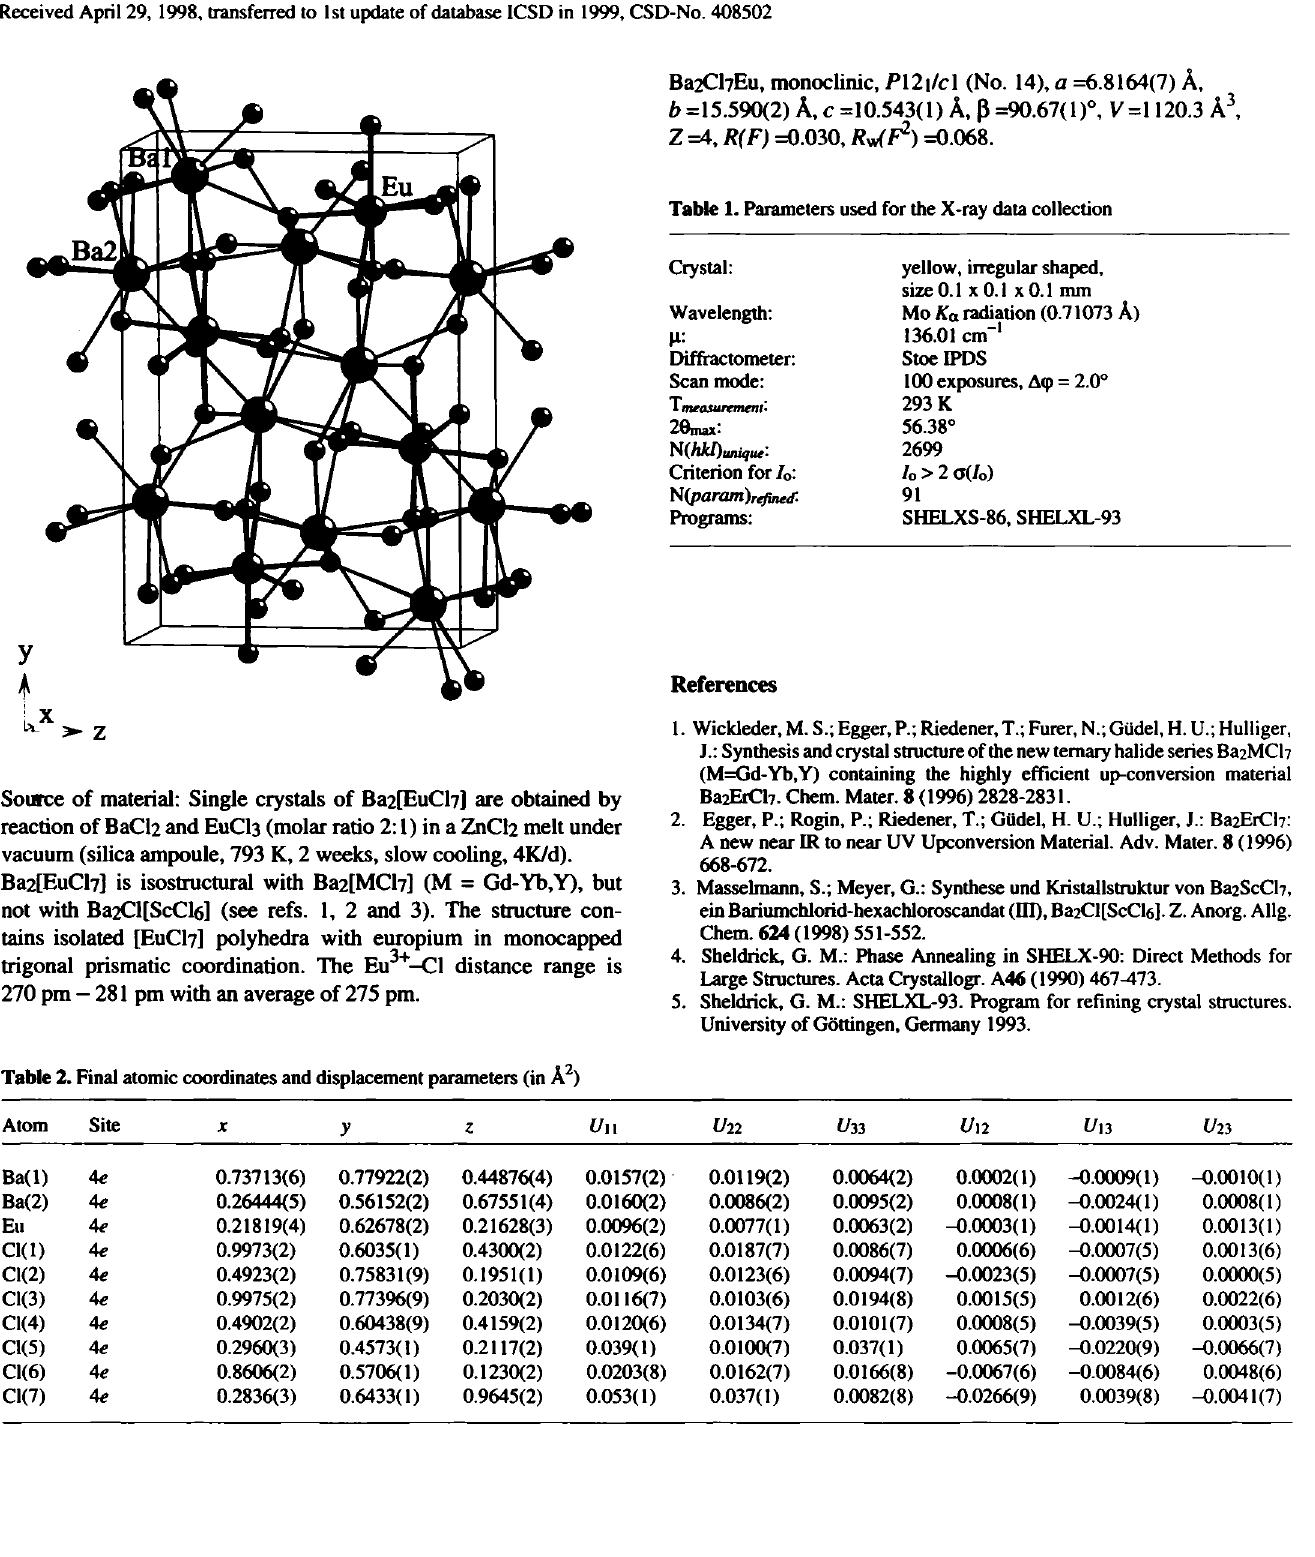
Table 1. Parameters used for the X-ray data collection Crystal: yellow, irregular shaped. size0.1 xO.I xO.l mm